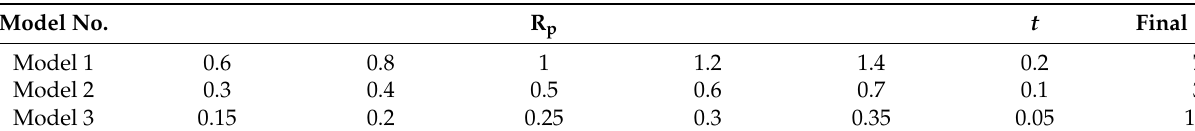
Table 7. Punch fillet radius and related parameters (unit: mm).